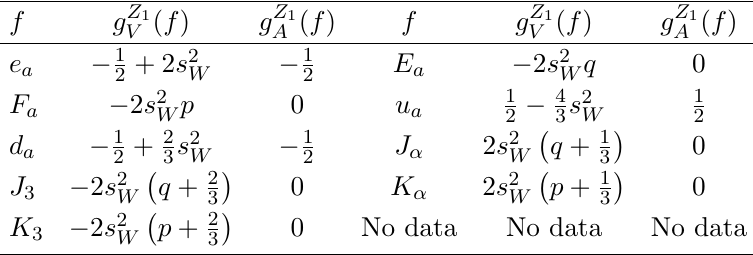
Table 5 . The couplings of Z